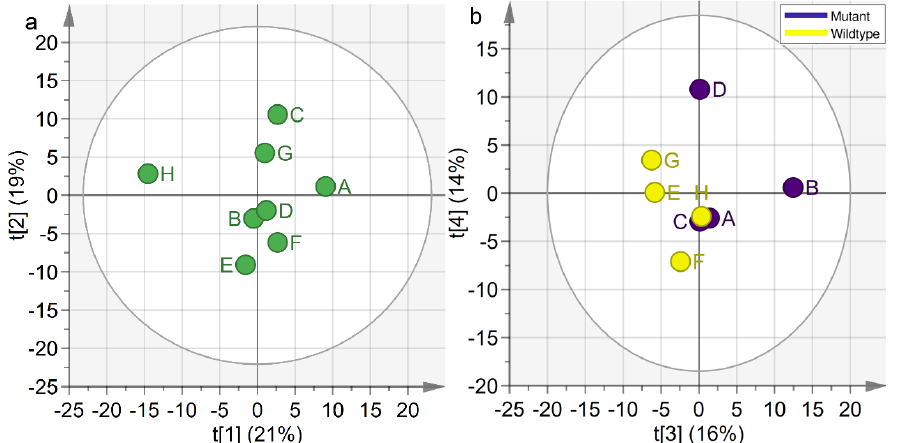
Figure 4. Concatenated PCA score plots. The percentages on the x- and y-axes indicated the amount of variation that was explained by each component. ( a ) Concatenated PCA t1 vs. t2. ( b ) Concatenated PCA t3 vs. t4. The circles were colored according to the genotype.